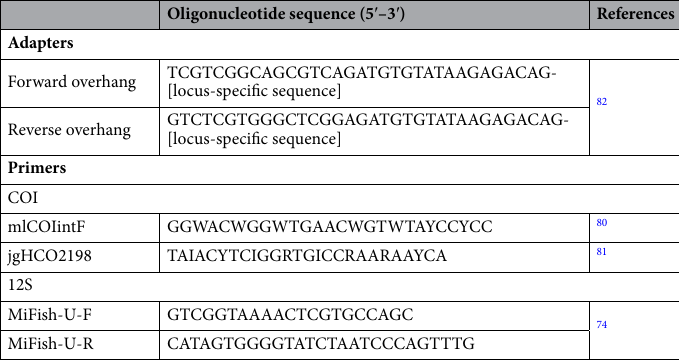
Table 2. Illumina adapters and primers used in the metabarcoding